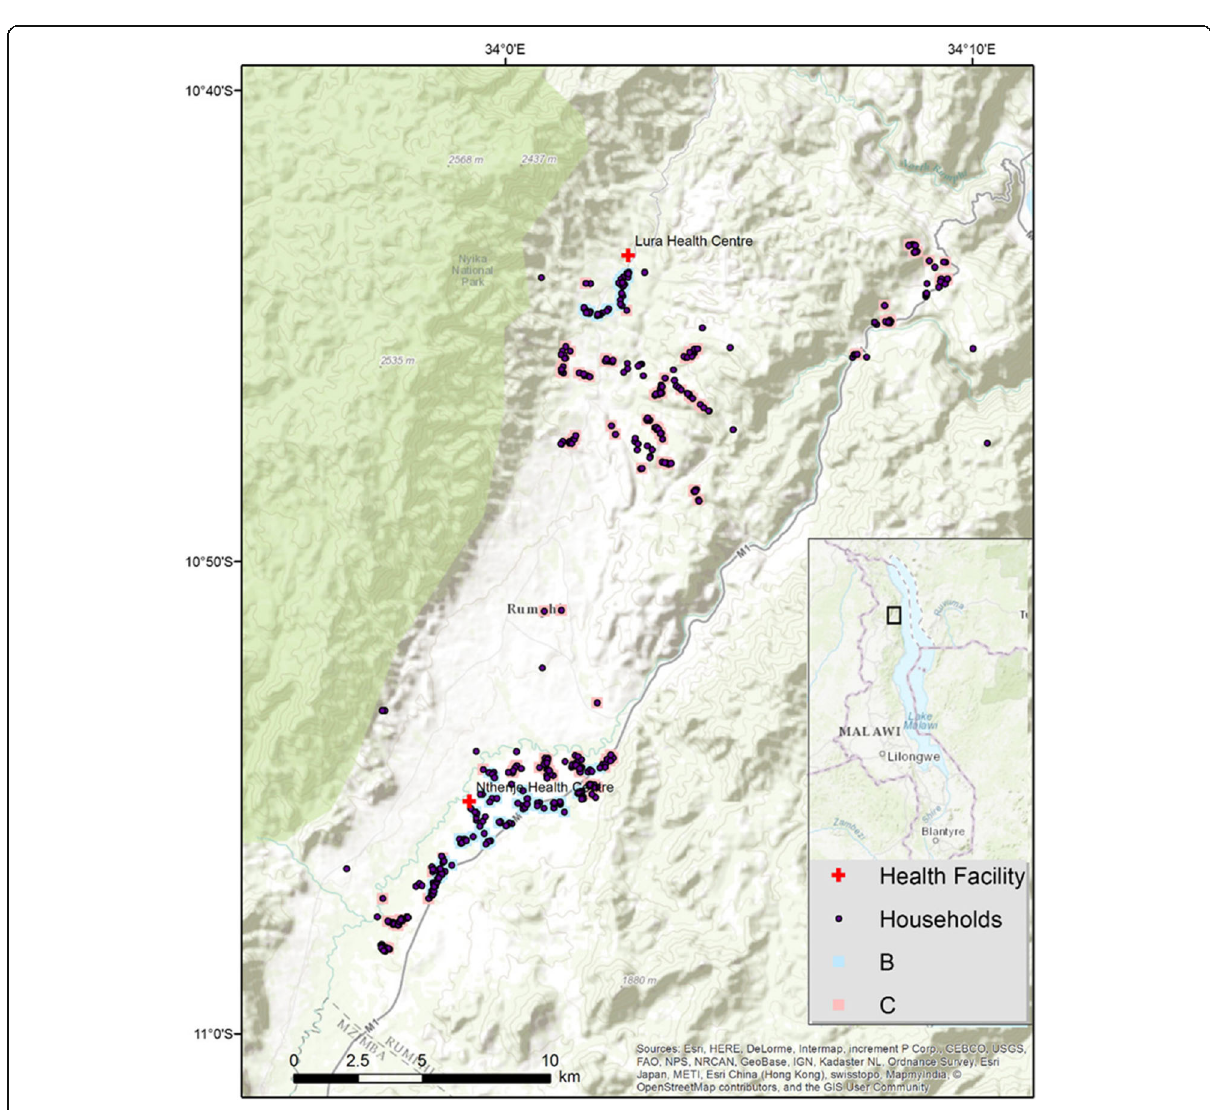
Fig. 2 Classification of households based on perceived and measured access, Rumphi, Malawi. Note: B and C refer to classification in Table 1 (divergence between perceived and measured